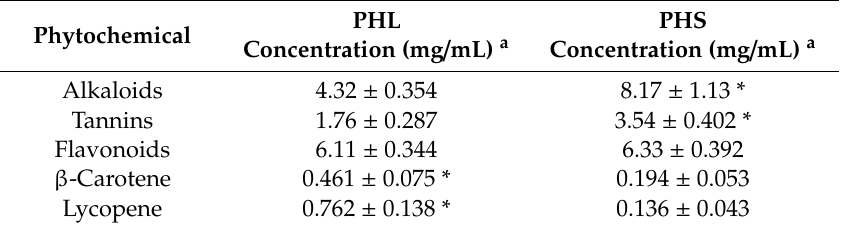
Table 1. Phytochemical constituents of P. hydropiper leaves and